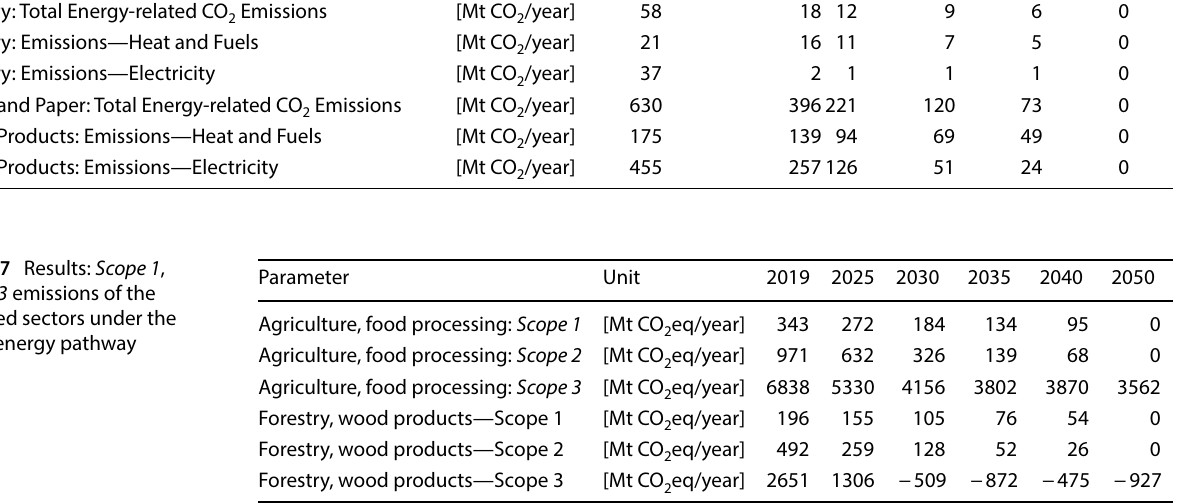
and forestry sectors have significant potential for on-site power generation using bio-energy and bio-waste/wood for power and heat production.